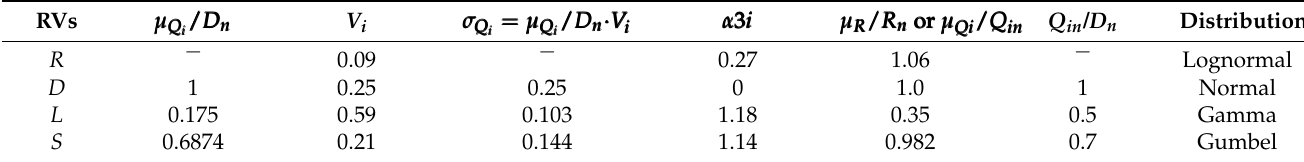
Table 3. Basic random variables for Equation (44).